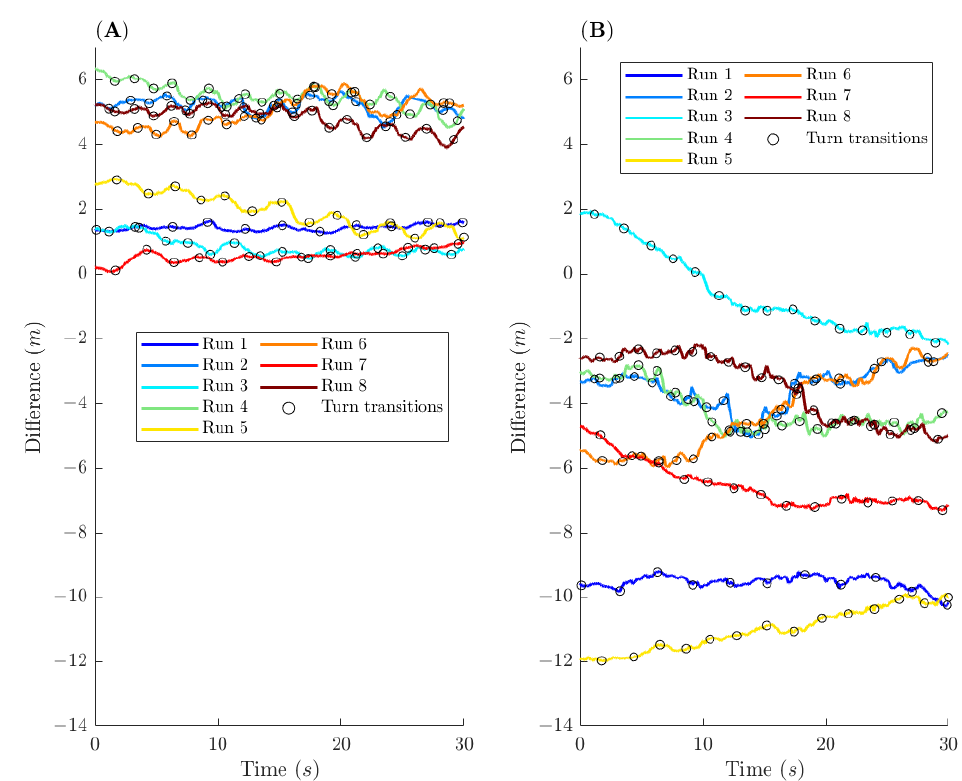
Figure 6. Error measurements for the first 30 s of the 8 first runs from competitive skiing day 1 on the same course. After each run, skiers took the lift to get back to the start and appeared again in this graph with the position error illustrated over 30 s. ( A ) Position error in the horizontal plane ( ∆ XY). ( B ) Vertical positional error. The horizontal axis shows time from start. Time zero represents the start time point for each run. Each line represents one run. The circles indicate turn start and end, represented by the deflection points between two turns.